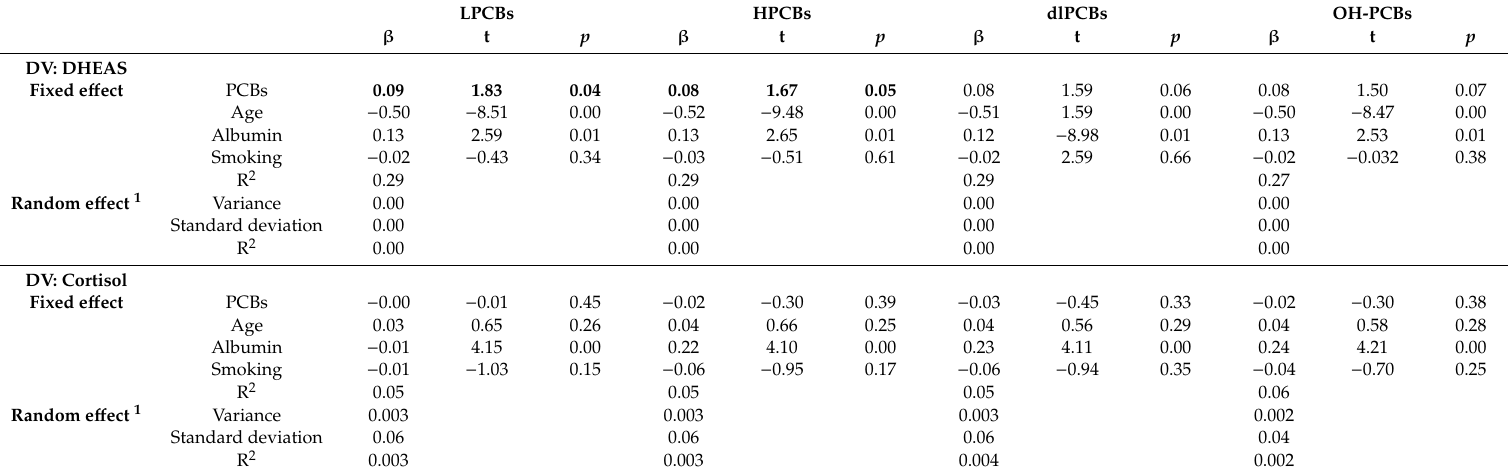
Table 7. Fixed and random e ff ects of the association between PCBs and the stress hormone concentrations of DHEAS and cortisol ( N =